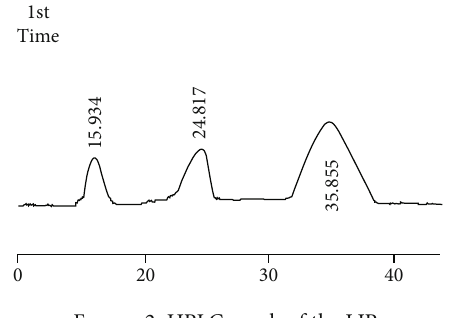
Figure 2: HPLC graph of the